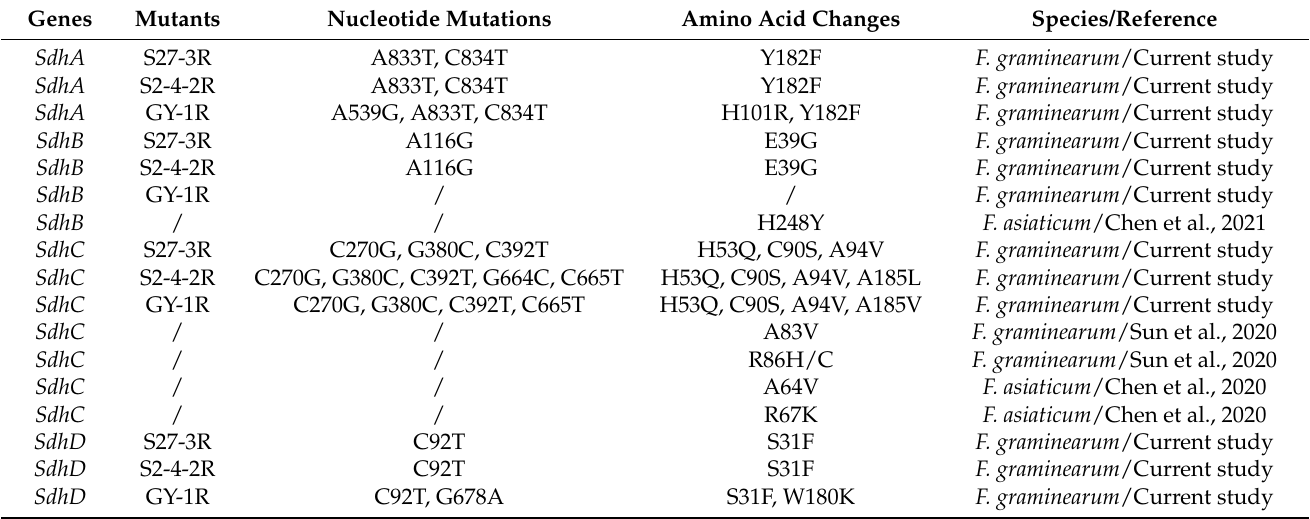
Table 2. Point mutations in Sdh genes associated with pydiflumetofen resistance in F. graminearum and F. asiaticum